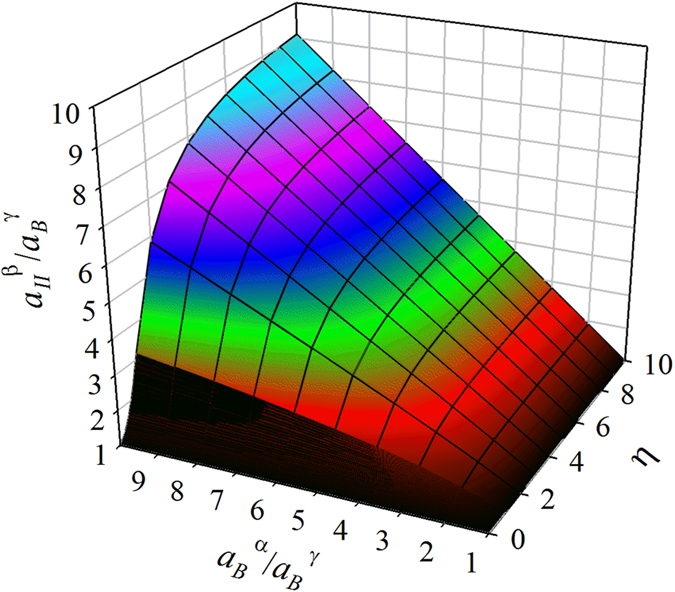
The variation of aIIβ with η and aBα, according to Eq. (8).